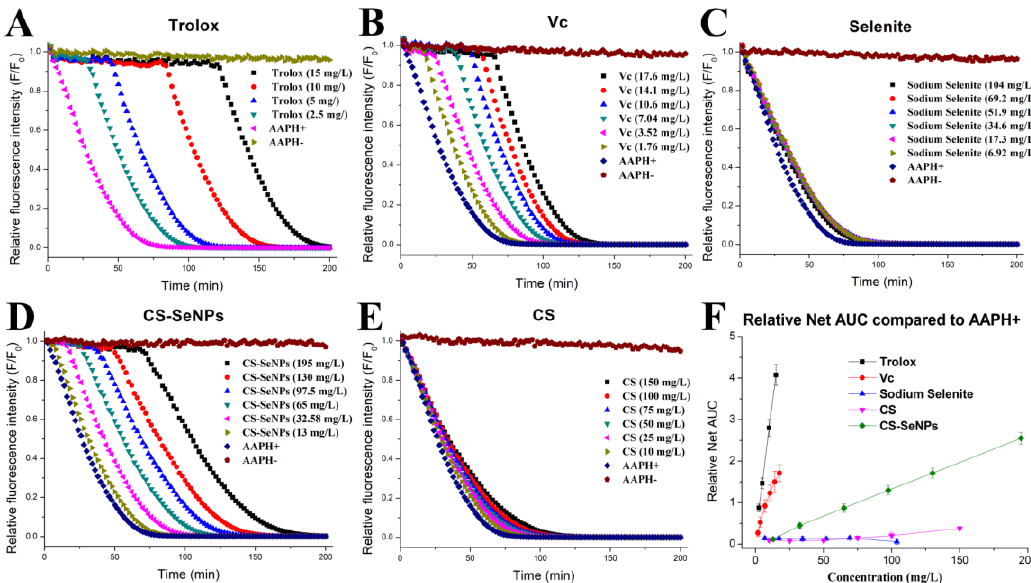
Figure 2. Effect of ( A ) Trolox, ( B ) ascorbic acid (VC), ( C ) sodium selenite, ( D ) CS-SeNPs colloid, and ( E ) CS on fluorescein consumption induced by AAPH and ( F ) dependence of the relative net area under the curve (AUC) upon the concentration of the compounds examined. Table 2. Oxygen radical absorbance capacity (ORAC) results ( n =